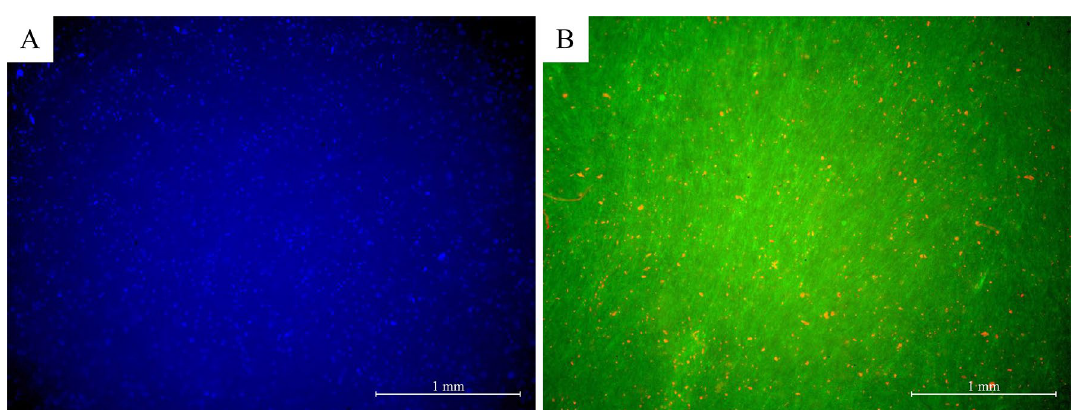
Figure 3. Survival of cells in the formed tissues on a GF sheet after maturation in the developed bioreactor. ( A ) DAPI stained nuclei, ( B ) Staining with Calcein-AM and Ethidium.